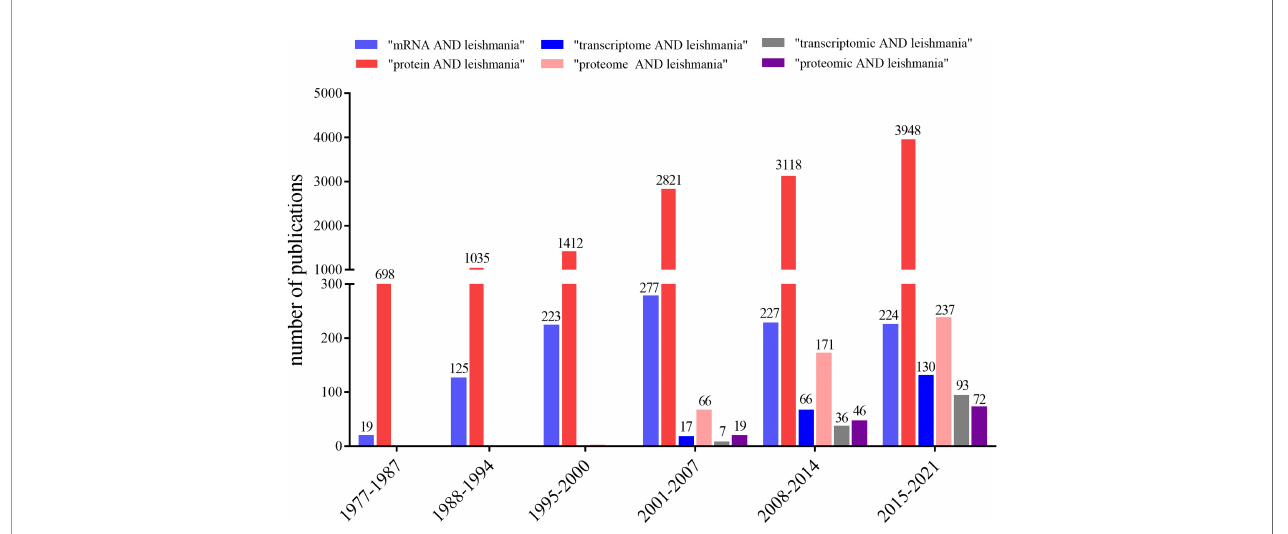
FIGURE 2 | Graph showing the number of publications retrieved in PubMed using the terms “ mRNA AND leishmania ” (light blue bars), “ protein AND leishmania ” (red bars), “ transcriptome AND leishmania ” (dark blue bars), “ proteome AND leishmania ” (pink bars), “ transcriptomic AND leishmania ” (gray bars), and “ proteomic AND leishmania ” (purple bars). The searches were conducted up to December